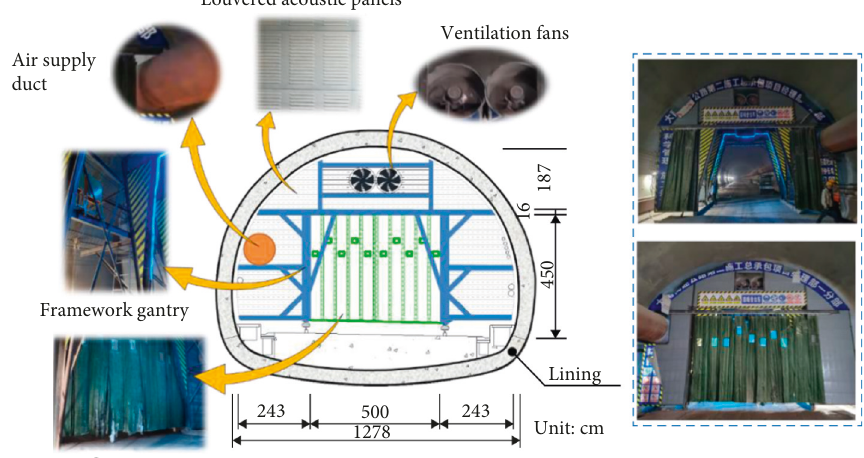
Figure 4: Description of NWBT.